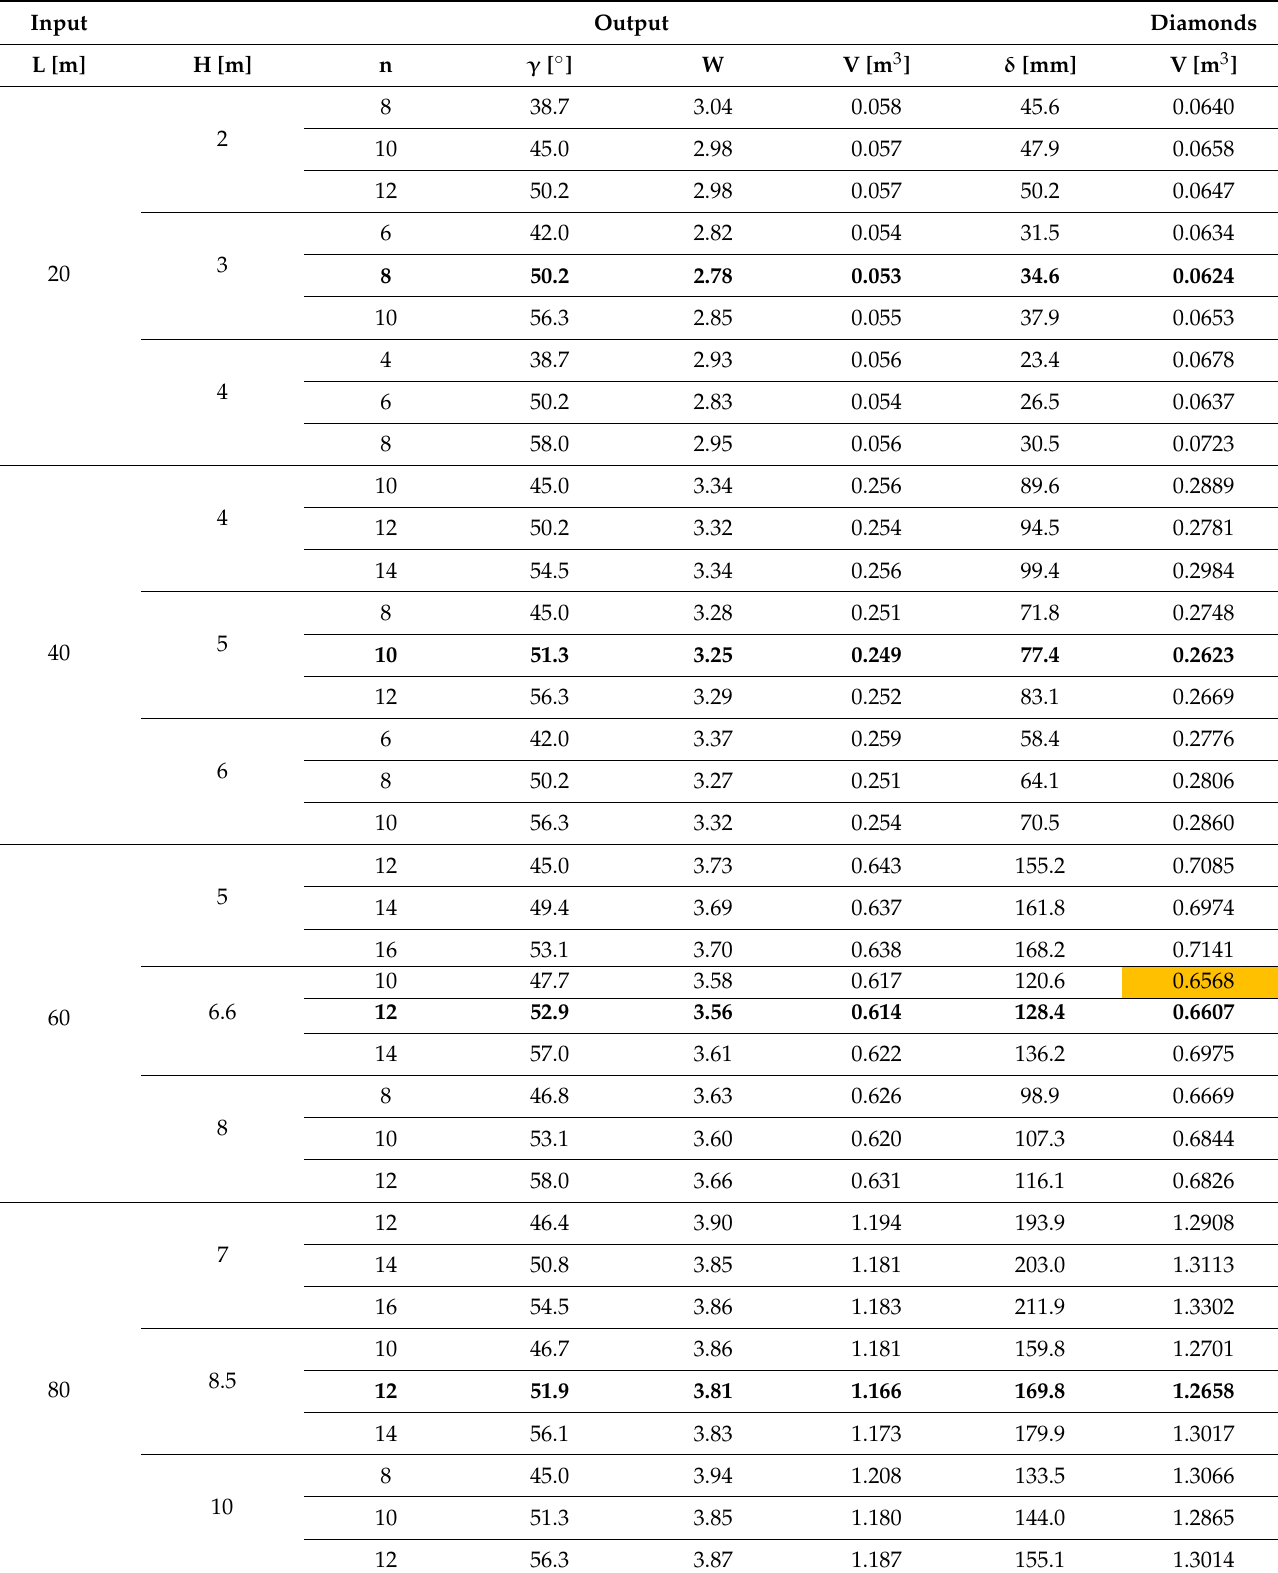
Table 2. Howe trusses (The most optimal result according to the software tool is indicated in bold, the results in Diamonds that deviate are highlighted in